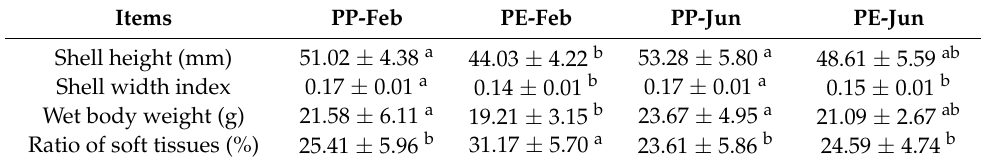
Table 1. Biological data of two P. f. martensii selective strains at different seasons. Items PP-Feb PE-Feb PP-Jun PE-Jun Shell height